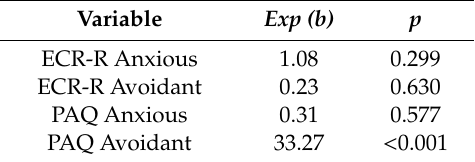
Table 5. Bivariate Relationships between Subscales and SED carer Group Membership.